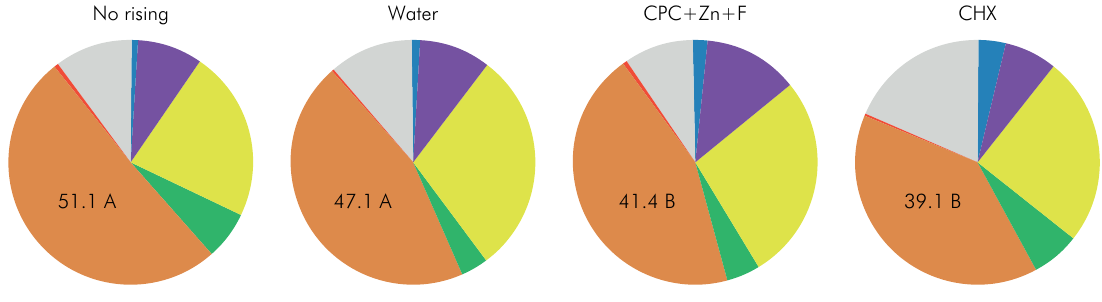
Figure 5. Pie charts of the mean proportion of each microbial complex in the four experimental groups. The colors represent different microbial complexes described by Socransky et al. 30 The significance of differences among experimental groups was assessed using the Kruskal-Wallis and Dunn tests (different capital letters indicate significant differences between groups, p <